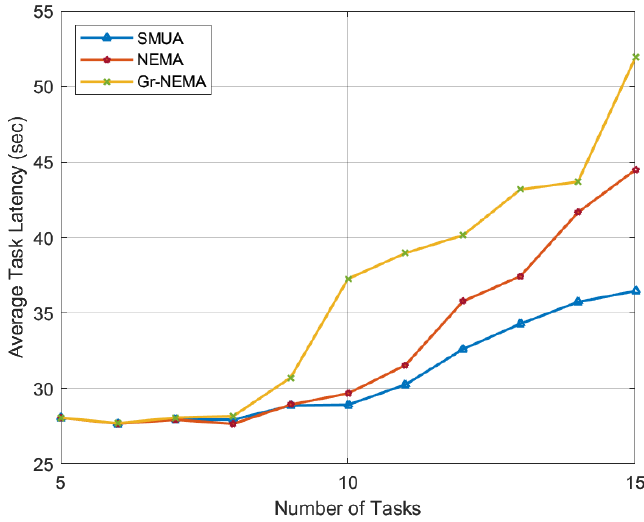
Figure 5. Average task latency with 3 matches permitted for each TN